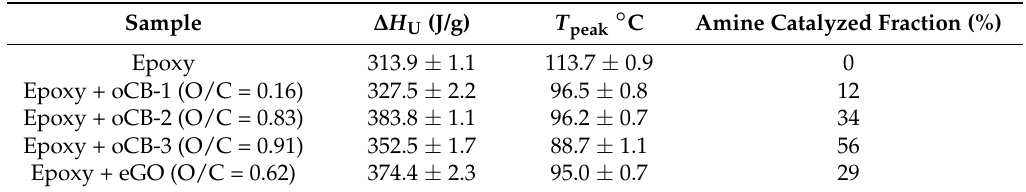
Table 3. Results of DSC scans at 10 ◦ C/min, for the neat epoxy resin and epoxy resins with 3 wt % of different carbon nanofillers: enthalpy changes, normalized with respect to the resin weight ( ∆ H U ), peak temperature ( T peak ), and fraction of catalyzed reaction.